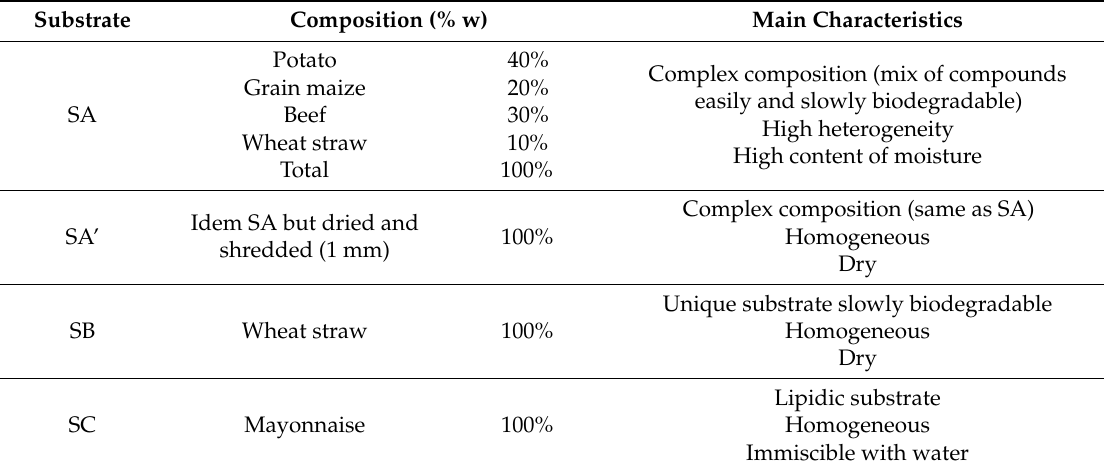
Table 3. Composition and main characteristics of the substrates used in the inter-laboratory study. Substrate Composition (%